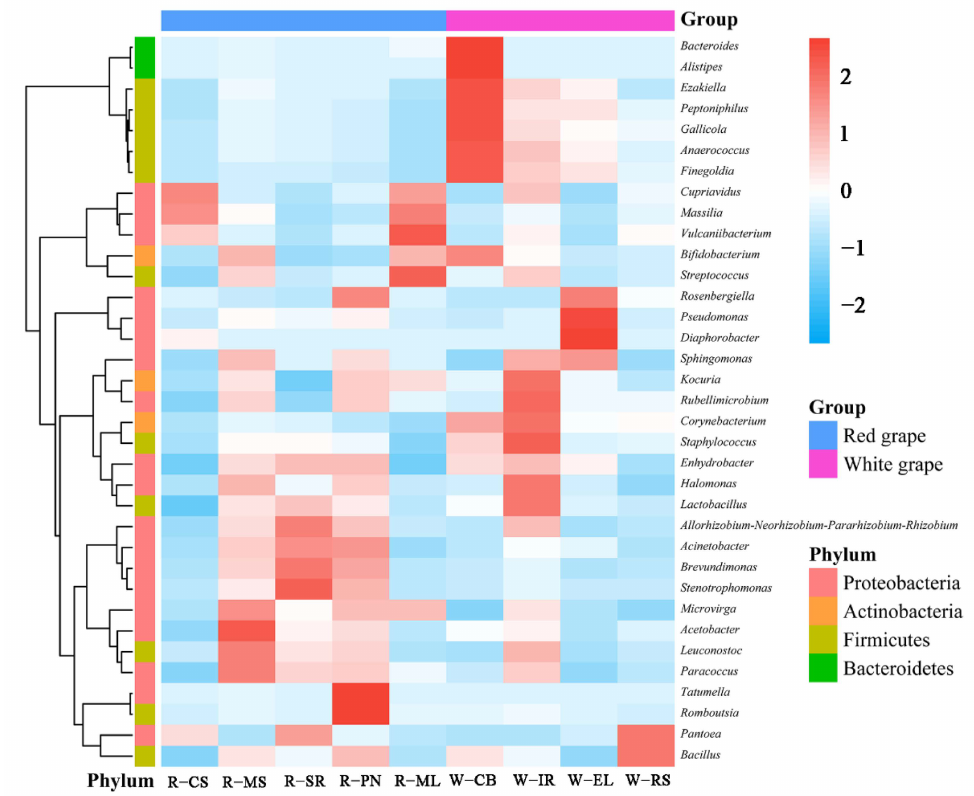
Figure 6. Heatmap of the top 35 abundant bacterial genera in different grape samples. Samples are clustered according to the similarity among their constituents and arranged in horizontal order. Red and blue represent the more and less abundant genera in the corresponding group,